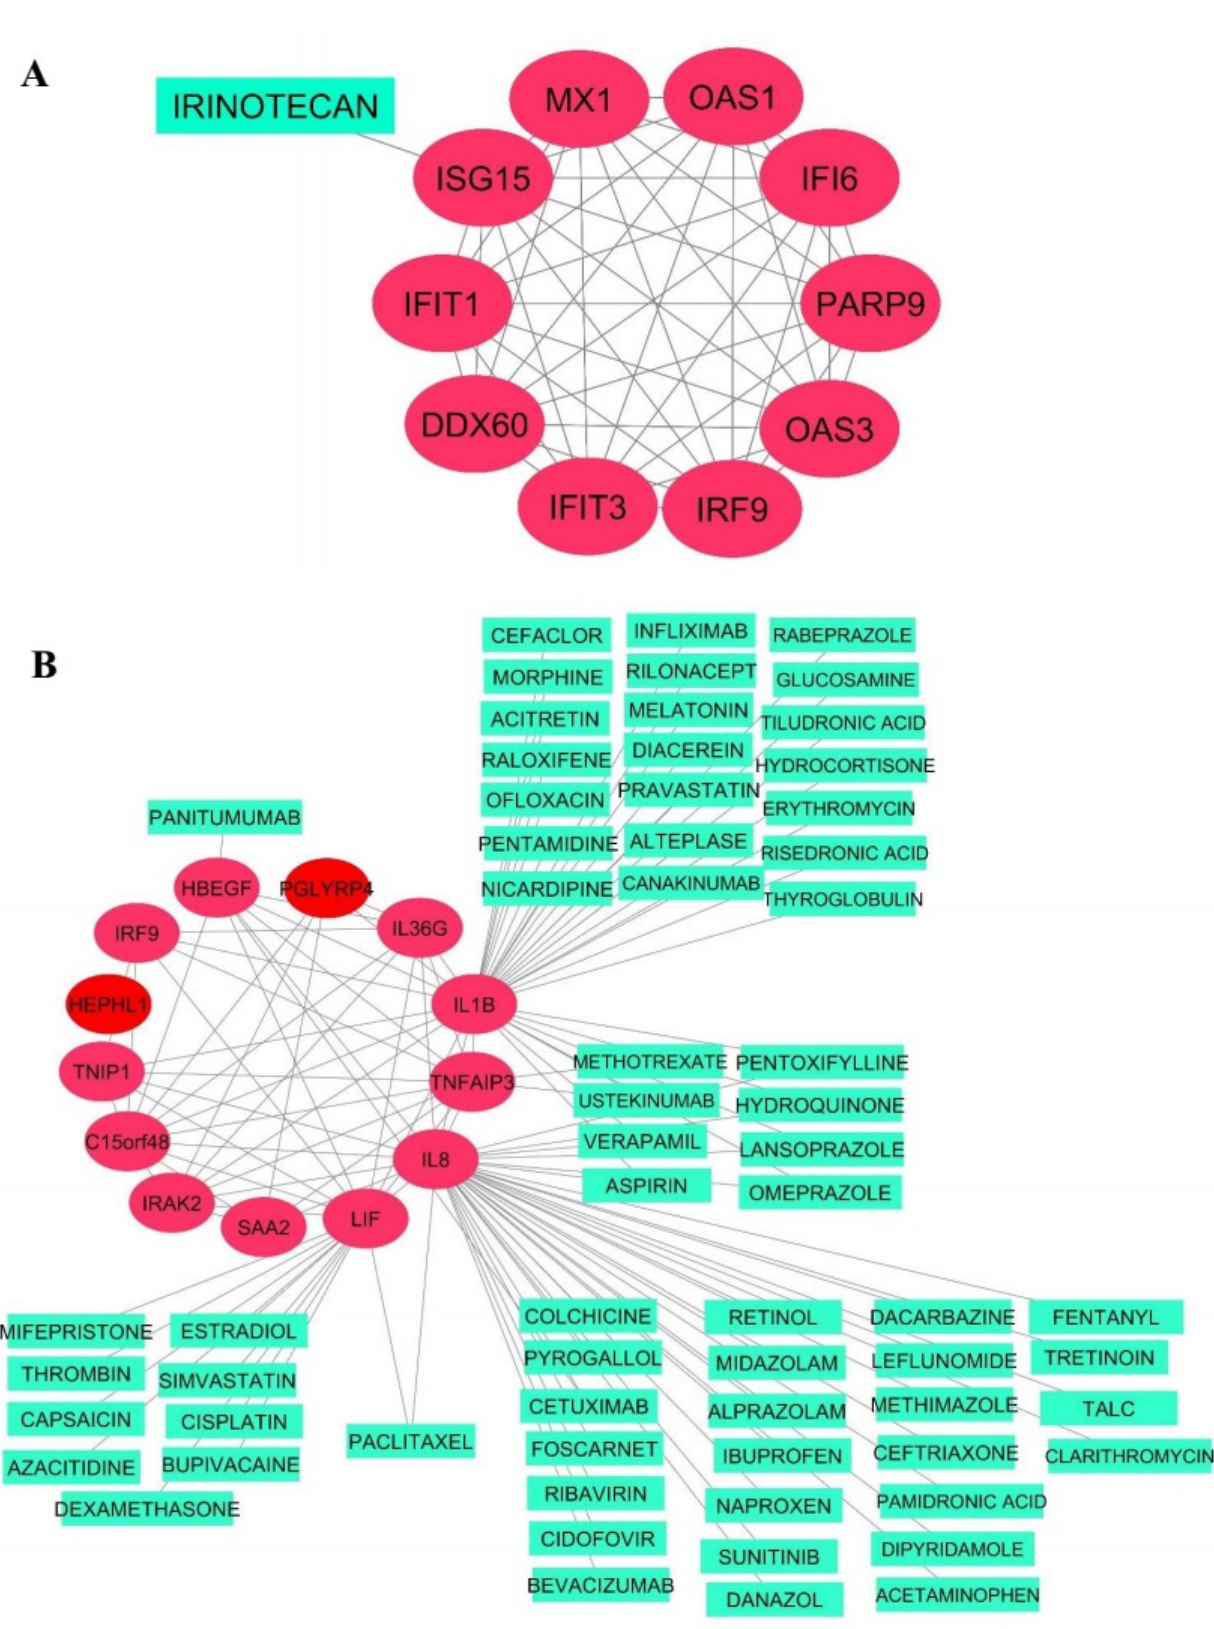
Figure 8. Co-expression network and related drugs of Turquoise ( A ) and Yellow-green ( B ) modules.